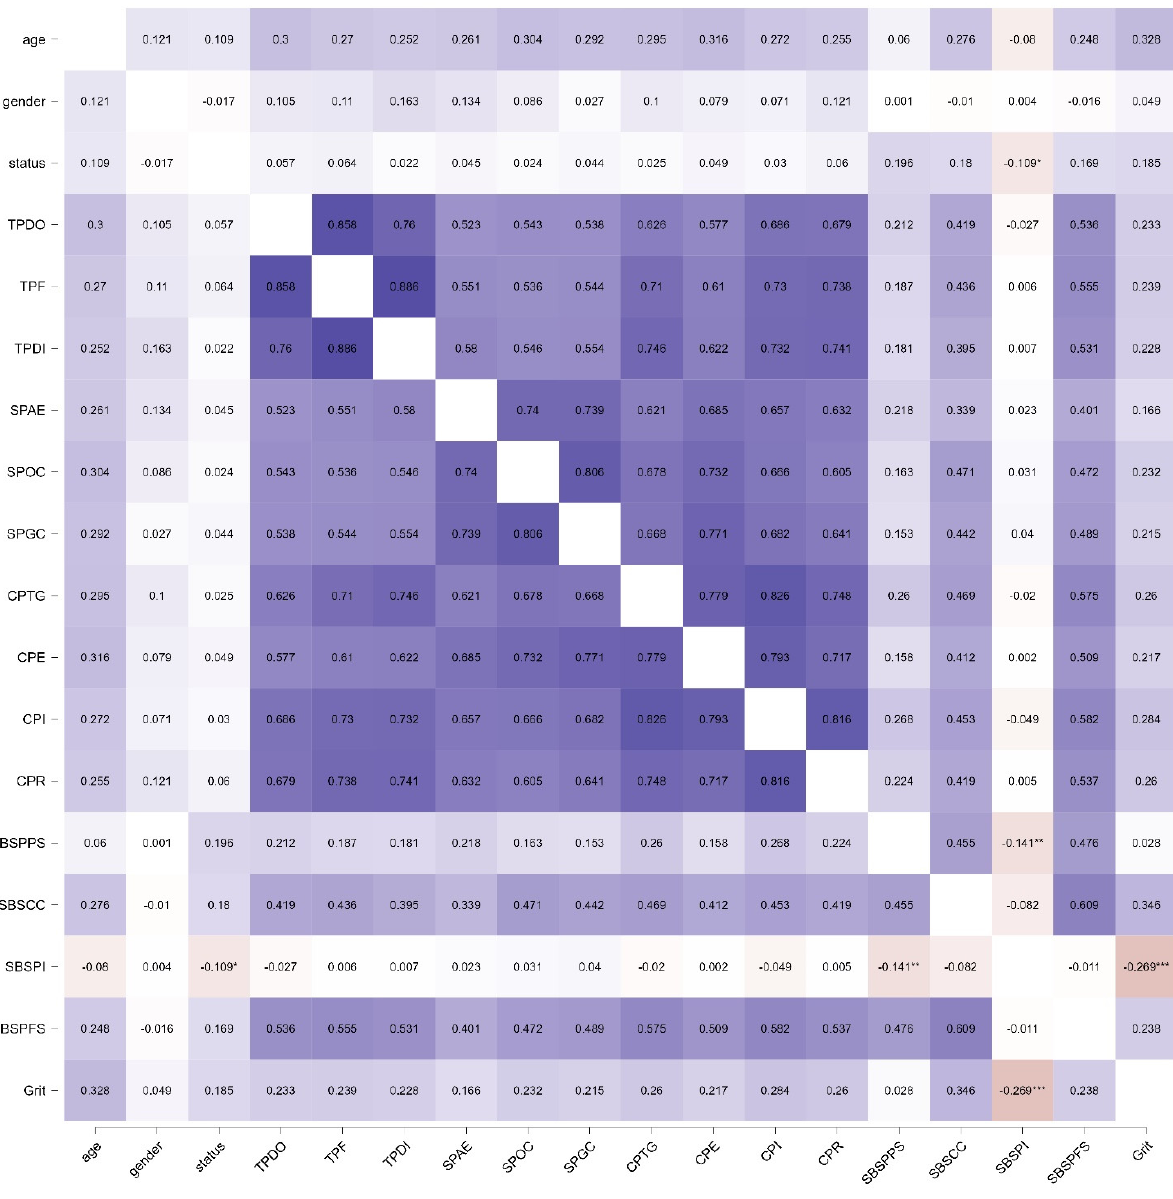
Figure 1. Heat map correlations. Note. * p < 0.05, ** p < 0.01, *** p < 0.001. Table 2. Gender